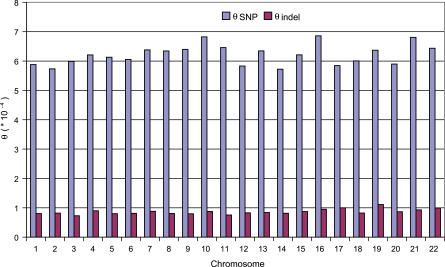
Diversity for SNPs and Indels in AutosomesThis is most likely an under-estimate of the true diversity, because a fraction of real heterozygotes were missed due to insufficient read coverage.